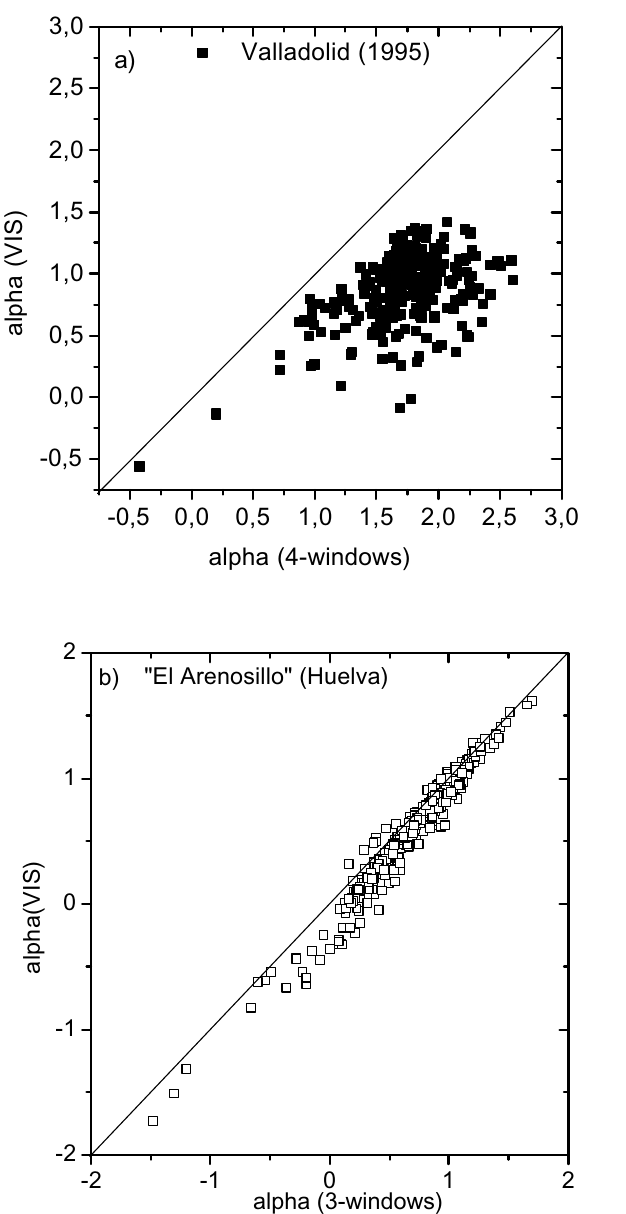
Fig. 3. Plots of the α parameter determined in the VIS range versus the values determined in the “window range” for a data of the north central station of Valladolid and b southwest coastal station of “El Arenosillo”-Huelva.